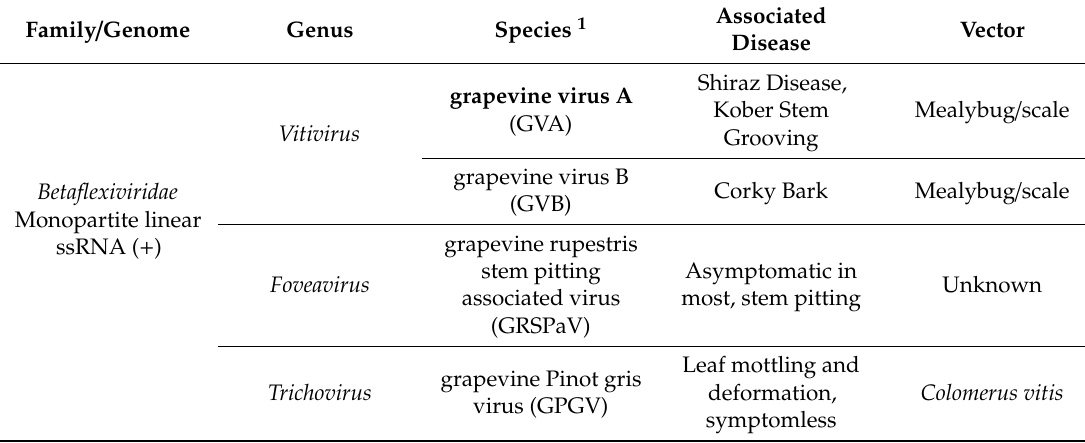
Table 1. Common grapevine viruses in Australia, their associated disease, and vectors. Viruses indicated in bold text are the focus of this